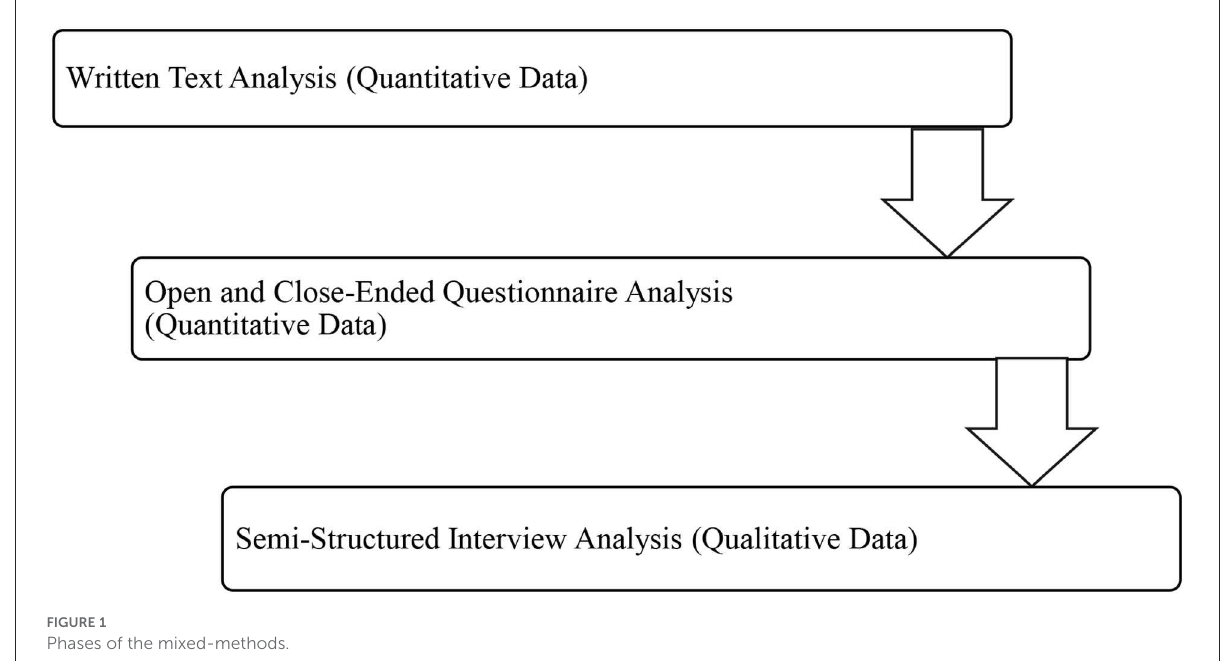
FIGURE1 Phases of the mixed-methods.